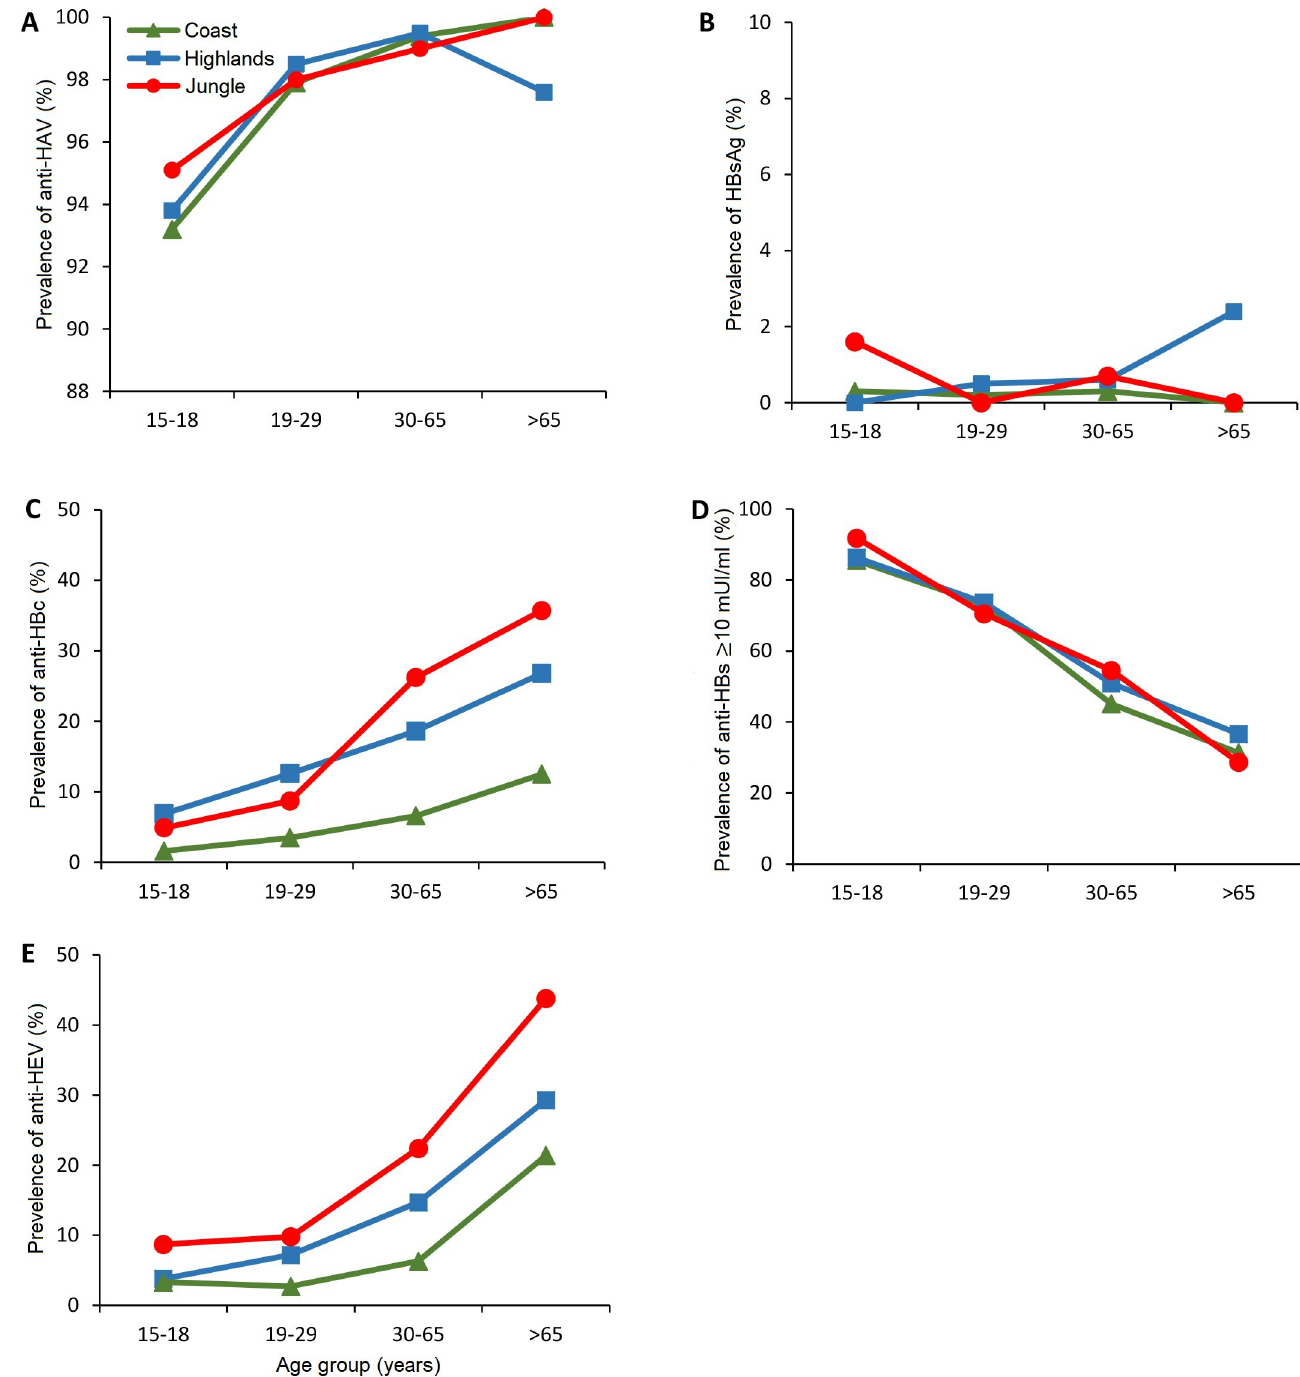
Fig 1. Prevalence rates of anti-HAV IgG (A), HBsAg (B), anti-HBc IgG (C), anti-HBs � 10 mUI/ml (D) and anti-HEV IgG (E) by age groups in different regions of Peru.